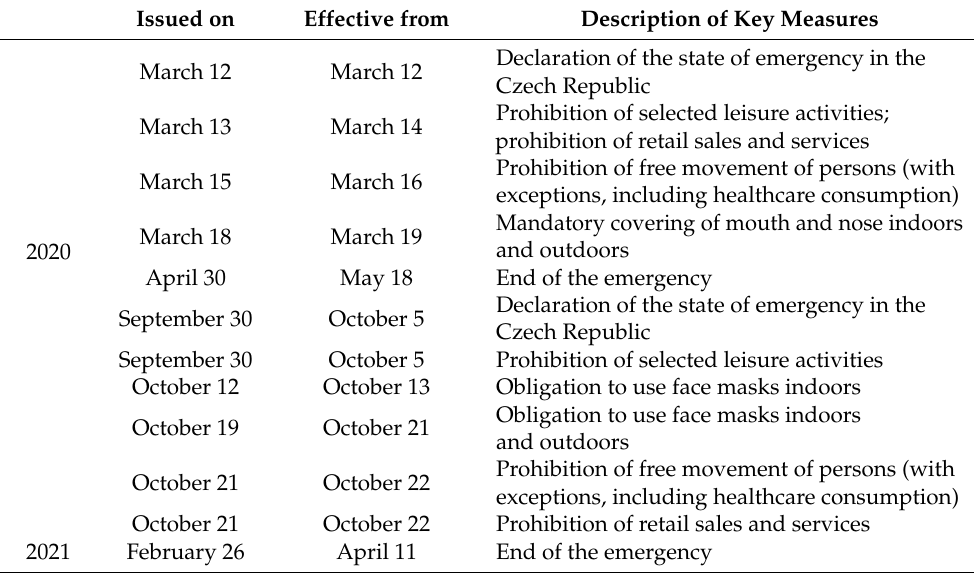
Table 1. Overview of selected key anti-pandemic measures issued by the Czech government. Issued on Effective from Description of Key